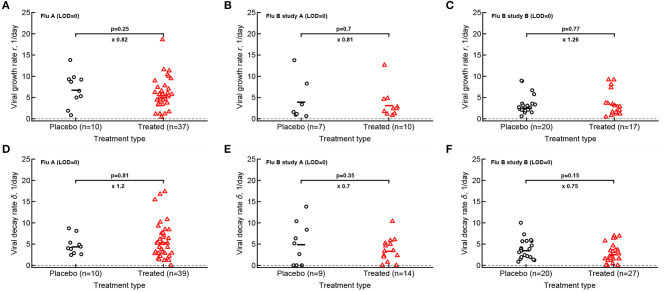
Oseltamivir treatment does not influence median viral growth and decline rates in individual volunteers. For the data from 3 clinical studies for every volunteer we calculated the rate at which viral shedding increased (A–C) or declined (D–F) with time for Flu A (A,D), Flu B study A (B,E), and Flu B study B (C,F) data. Only volunteers with the data above limit of detection (LOD) and at least two data points for virus increase to the peak or virus decline after the peak were included. Horizontal lines denote median values. The number of volunteers, n, analyzed in each of the trial and tests is shown on the x-axis of each graph. Comparisons between groups done using Mann–Whitney test, magnitude of the effect is indicated as × fold change, and p values from the test are shown on individual panels.